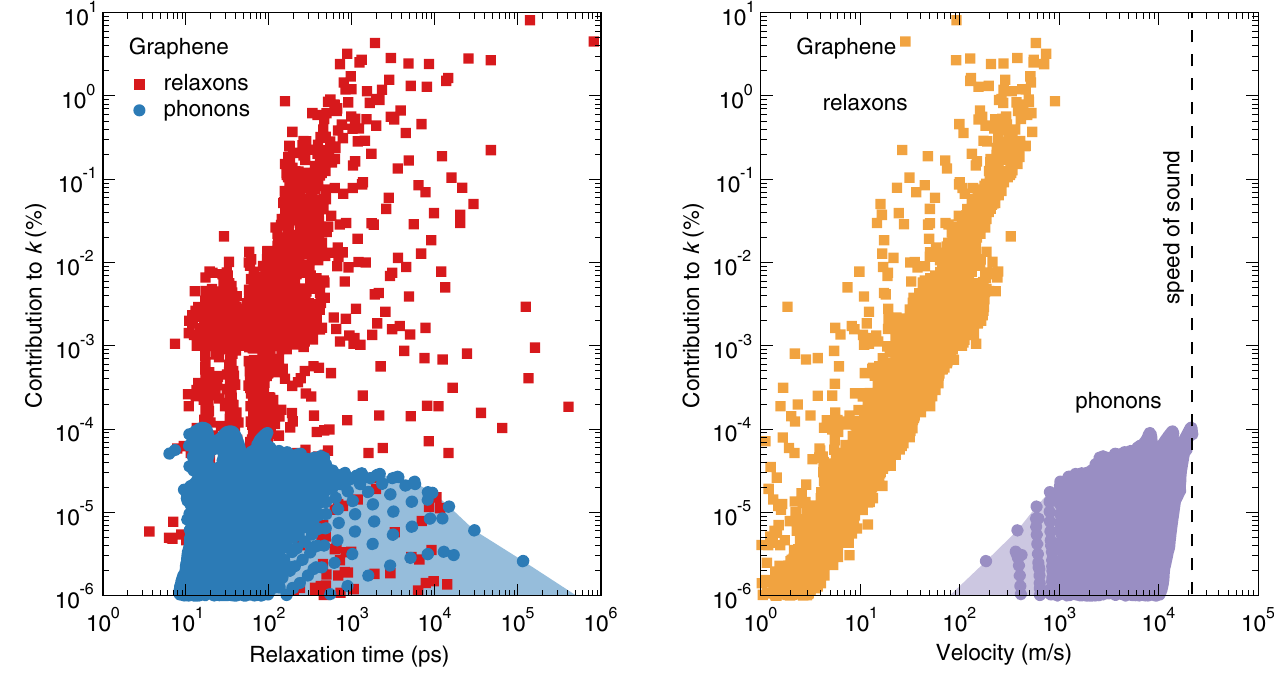
FIG. 3. Relaxation times and their contribution to the thermal conductivity of graphene at room temperature, considering relaxons or phonons as heat carriers. Relaxons tend to be longer lived than single phonon excitations, with large contributions to thermal conductivity coming from excitations with relaxation time larger than 10 3 ps, whereas phonons have lifetimes mainly in the range 10 – 100 ps. The shaded area is a guide to the eyes to stress that phonons form a continuous spectrum, while relaxons are discretized; thermal conductivity can be accurately described using a small number of relaxons.